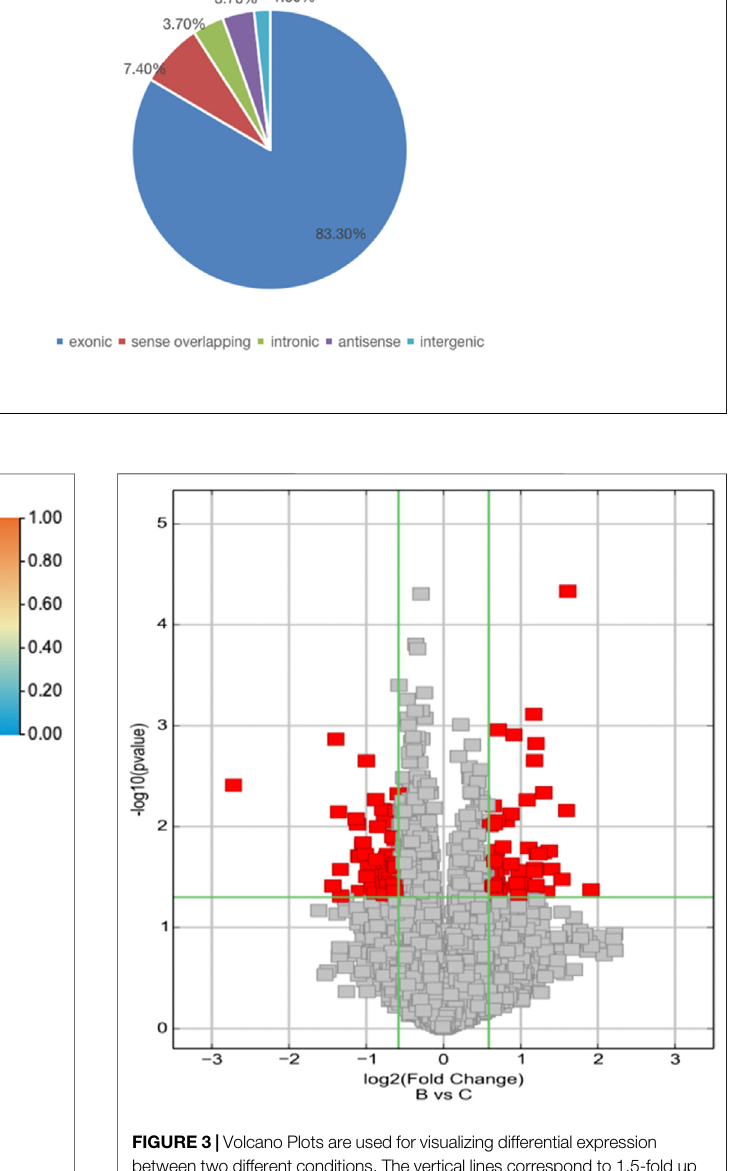
FIGURE 2 | The hierarchical clustering of differentially expressed circRNAs. “ Red ” indicates high relative expression, and “ green ” indicates low relative expression. Group B represented unruptured intracranial aneurysm samples, group C represented ruptured intracranial aneurysm samples.